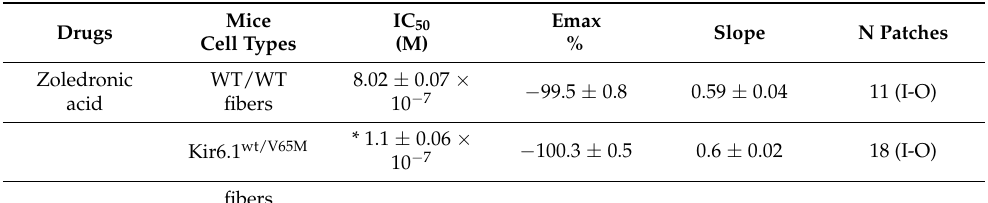
Figure 2. Concentrations-response relationships of glibenclamide concentrations vs. KATP current percentage inhibitions in FDB skeletal muscle fibers from SUR2 A478V homo and heterozygous and Kir6.1 wt/VM CS mice. The experiments were performed in excised macropatches from isolated fibers in the presence of high KCl on both sides of the membrane patches during voltage steps from 0 mV to − 60 mV (Vm). The drug solution was applied on the intracellular side of the patches. The concentration–response curves of glibenclamide to reduce the KATP channel currents were significantly shifted to the right on the log concentration axis concerning the controls in homozygous SUR2 AV/AV and heterozygous Kir6.1 wt/VM CS mice. Each point of the concentration–response curves was obtained on 12–28 patches. Table 1. Fitting parameters of the concentrations-response relationships in different Cant ú syndrome (CS) mice genotypes and